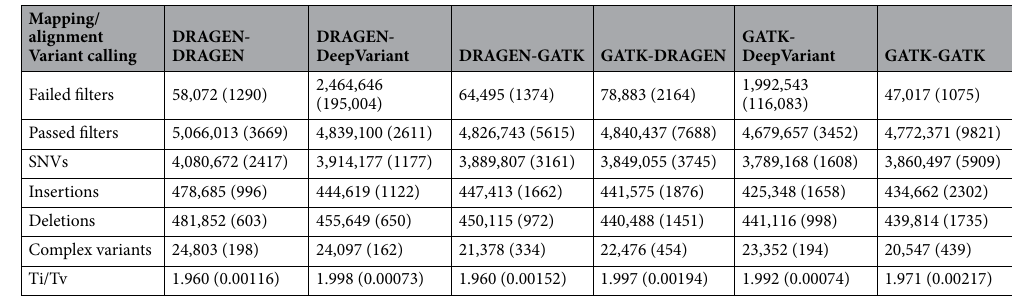
Table 1. Comparison of variant counts for the 6 pipelines with HG002 sequenced 70 times in different runs. Displayed are means and standard deviations (in parenthesis). Target sensitivities of 99.95% for SNVs and 99.75% for Indels were used for pipelines involving the GATK Haplotypecaller. SNV single nucleotide variation, Ti/Tv transition/transversion.